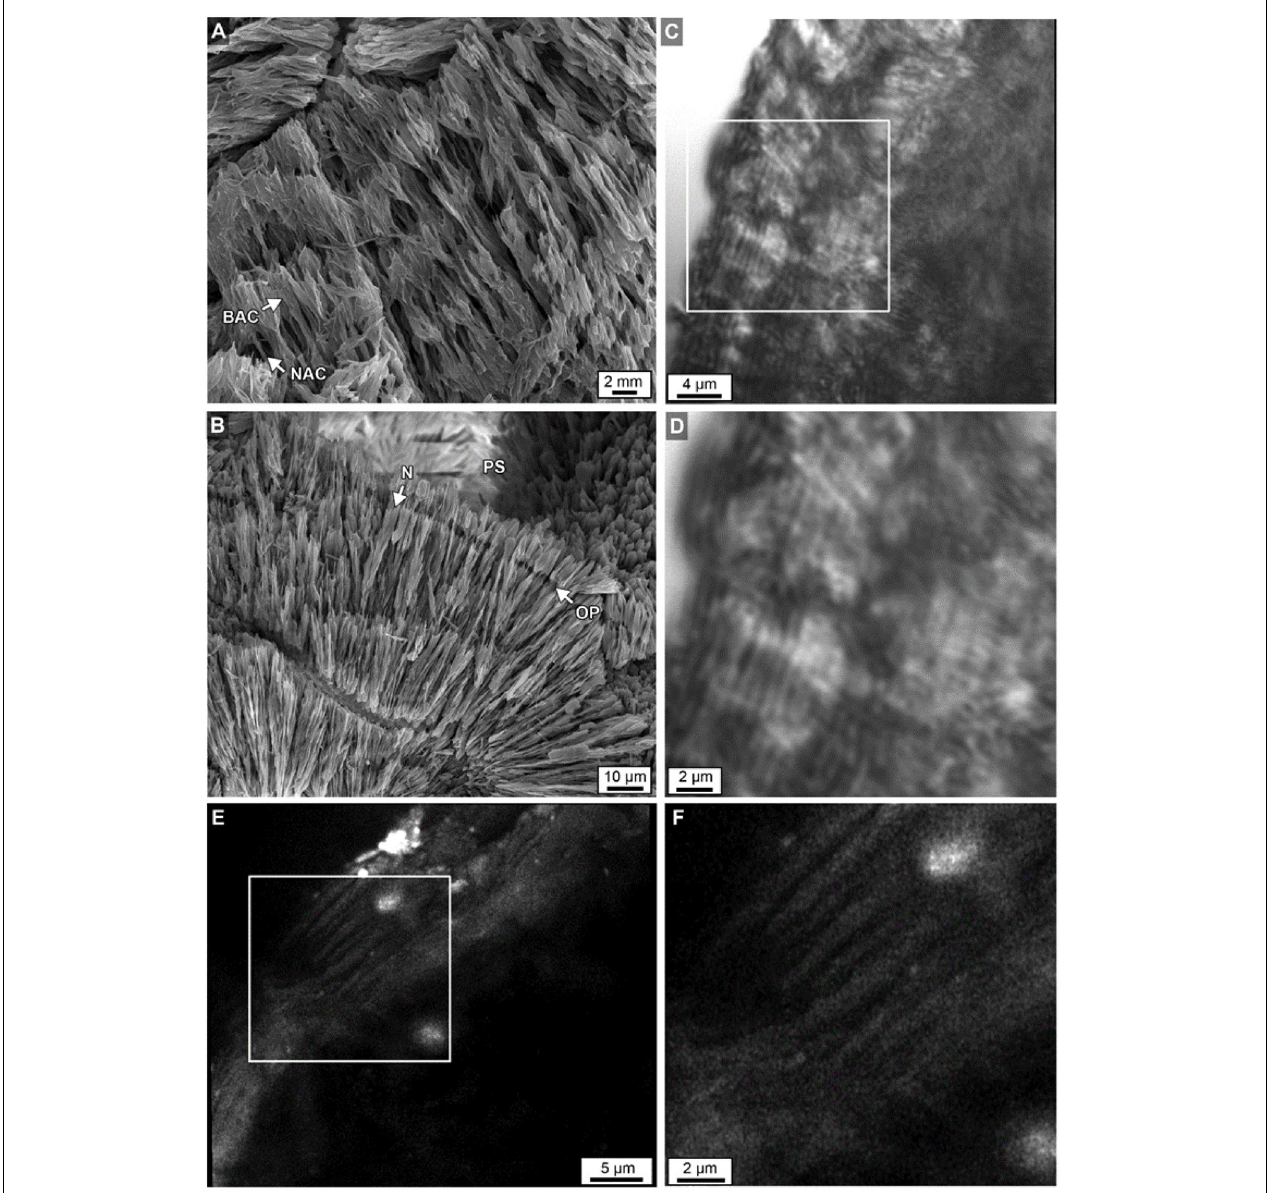
FIGURE 12 | (A) Acicular aragonite morphology making up dark white bands constituting narrow aragonite crystals (NAC) and broad aragonite crystals (BAC) as described in Figure 11 . (B) Margins of original porosity (OP), pore space (PS) and aragonite needles (N) are depicted. (C) Laser transmitted light images of etched skeleton at the growing uppermost top surface of Core 3 showing concentric higher frequency (200–250 nm-thick) layering within sclerodermites (dark = organic matter; light = crystalline). (D) Magnified image in box C . (E) Airyscan SRAF image showing organic matter in the same etched skeleton at a different location showing high frequency layering ( Supplementary Data Movie S3 ). (F) Enlargement of image from box in E